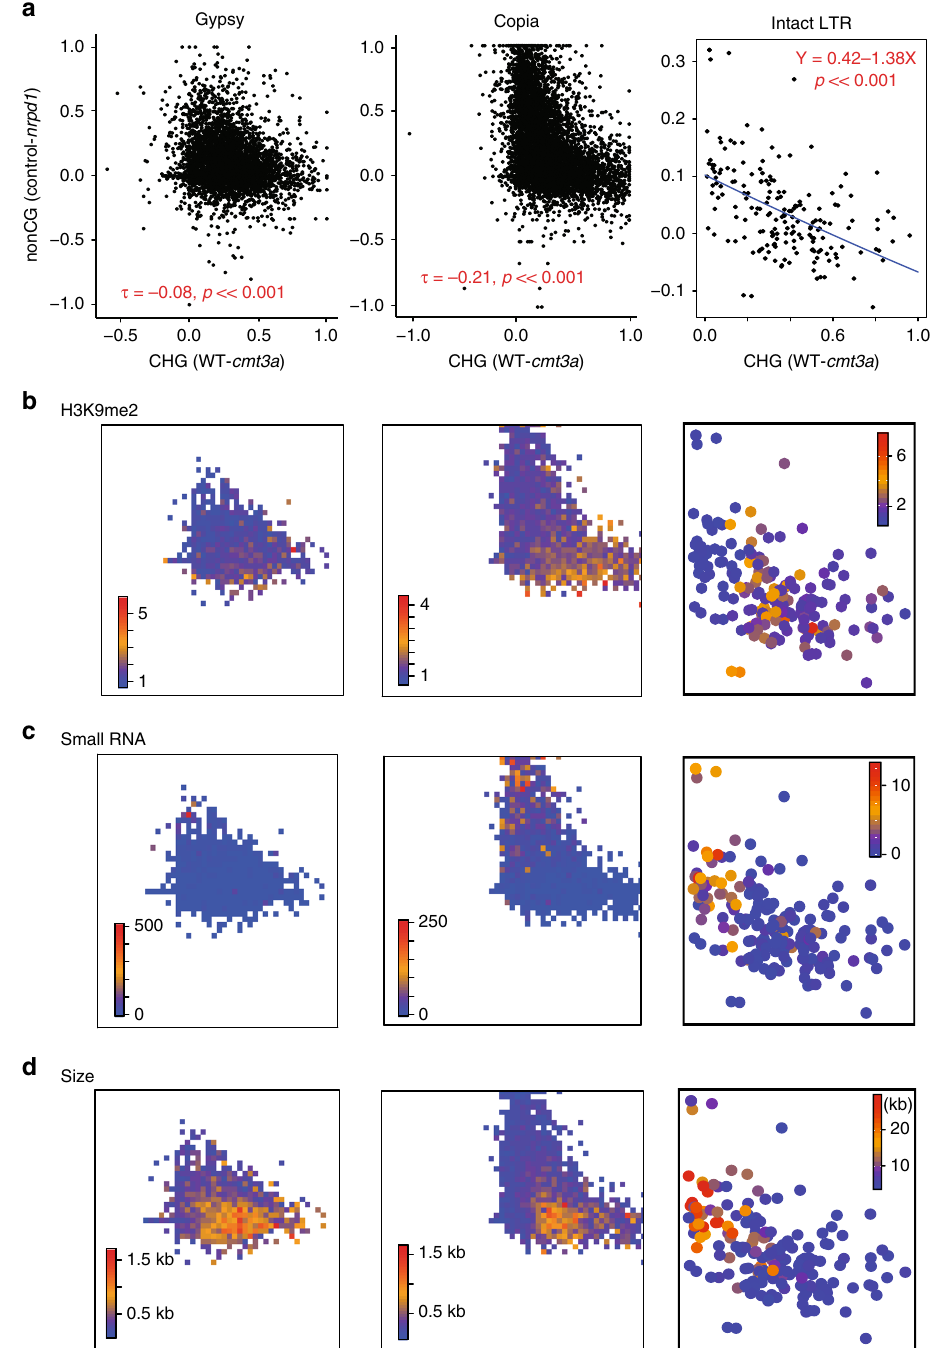
Fig. 3 CMT3a-mediated CHG methylation anti-correlates NRPD1-mediated non-CG methylation in distal LTR TEs. a Scatter plots of hypomethylation of each TE. X -axis represents the reduction of CHG methylation in cmt3a , y -axis represents the reduction of non-CG methylation in nrpd1 . Kendall ’ s tau test is performed for Gypsy and Copia. The Kendall rank correlation coef fi cients and p values relative to the null hypothesis of no correlation are indicated in red. Linear regression is performed for intact LTRs (the blue line). Regression model and the p-value relative to the null hypothesis that the line has zero gradient are indicated in red. b – d H3K9me2 ( b ), small RNA ( c ) and size ( d ) pro fi ling of each TE. For Gypsy and Copia, color key represents average levels of H3K9me2 ( b ), small RNA ( c ) or size ( d ) of no less than three dots within each colored square. For intact LTR, color key represents levels of H3K9me2 ( b ), small RNA ( c ) or size ( d ) of each